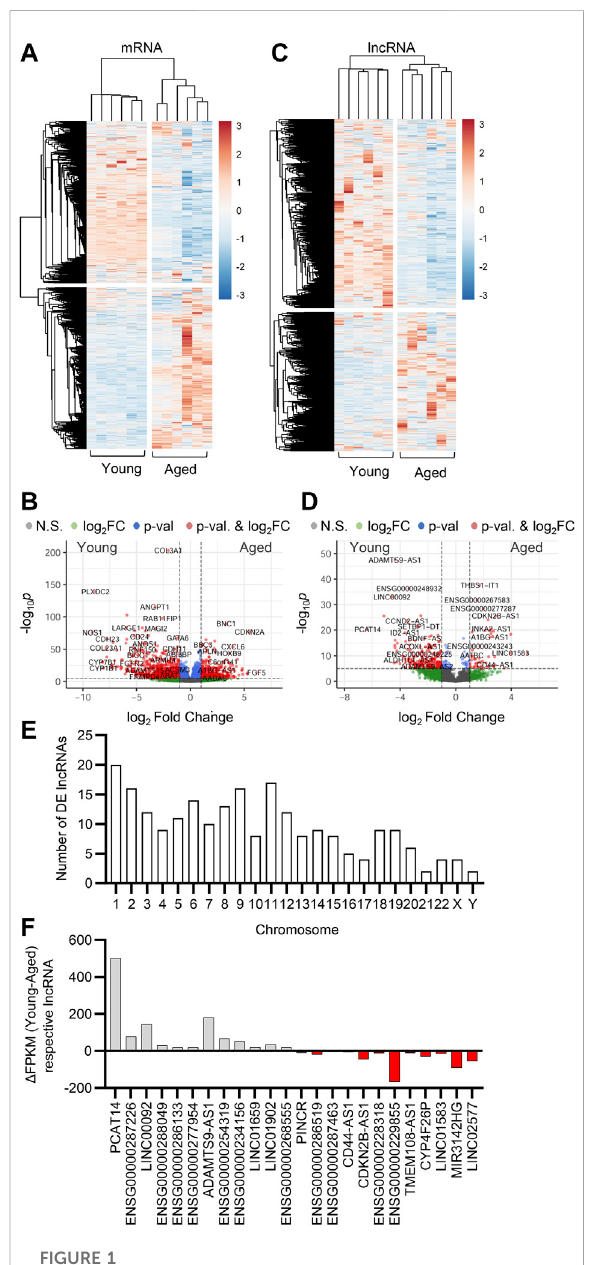
FIGURE 1 Effect of aging on endothelial cell transcriptome. Bulk RNA- sequencing analysis was performed in human native young and aged arterial endothelial cells ( n =6 per group, each sample is a pool of 5 different isolates). (A,C) Hierarchical clustering heatmap showing differentially expressed mRNAs (A) and lncRNAs (C). (B,D) Representative volcano plots showing differentially expressed mRNAs (B) and lncRNAs (D) (total mRNA variables = 15,379, total lncRNA variables = 4,463). (E) Chromosome distribution of differentially expressed (DE) lncRNAs detected as in (C) and (D). (F) Expression levels presented as Δ FPKM of lncRNA transcripts detected in panels (C) and